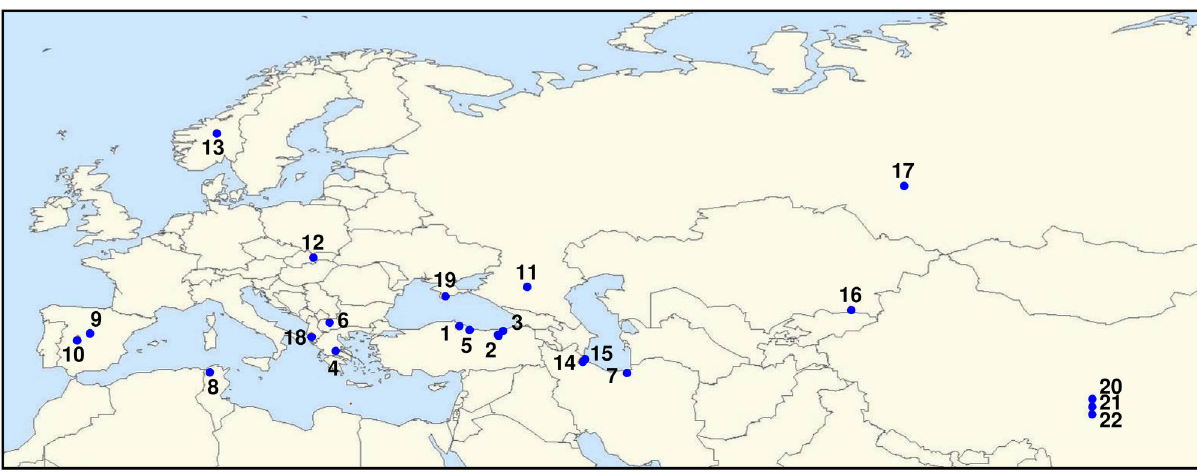
Figure 2. Approximate collection locations for the lines used in this study. All locations were inferred from the collection information found in the Plant Inventory accessed through the GRIN database. For most lines the town nearest the collection site was mapped. Locations 20-22 were mapped using the GPS coordinates of the collection locations. For location 4 and 12 only the country of origin was listed so the map location indicated is the approximate center of the country. See Table 1 for location number to accession assignments. For complete collection data see Figure S1. doi: